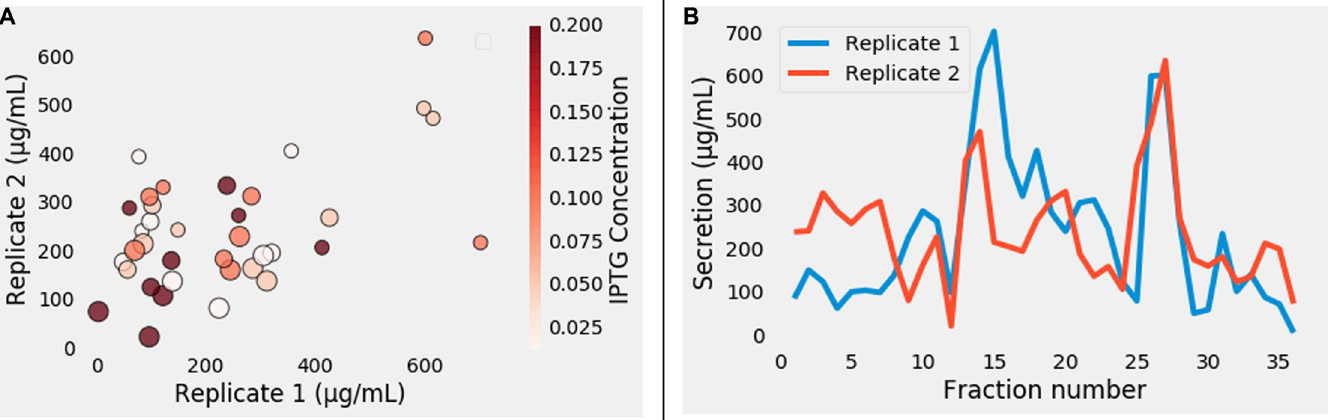
Fig 11. Evaluation of the secretion trend and reproducibility. (A) Indicates the trend of protein secretion in various fractions. (B) To evaluate the reproducibility of secretion replicates, Pearson correlation between the two sets was calculated and the secretion experiments were found to be in good agreement as revealed by a Pearson correlation coefficient of 0.5 and p-value of